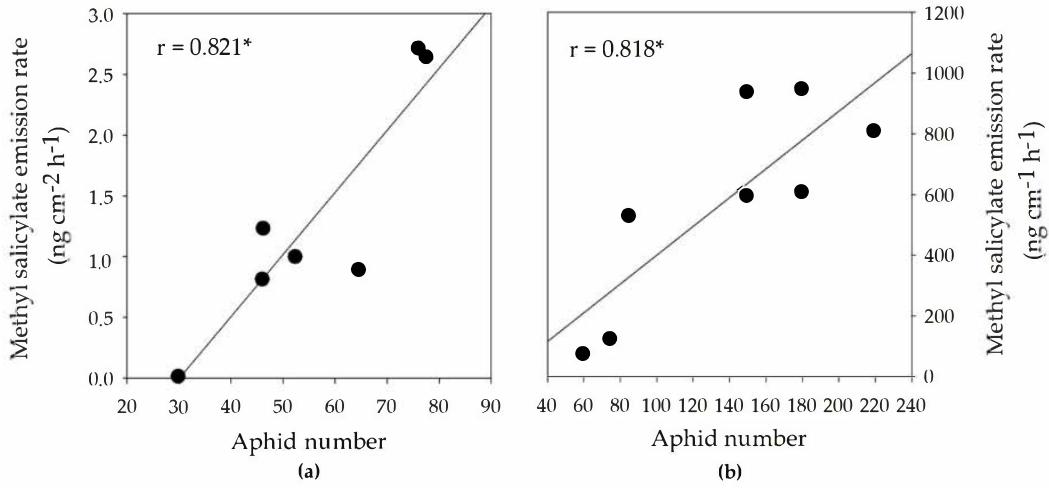
Figure 3. Relationship between the emission rate of methyl salicylate and the number of living aphids. ( a ) Daily average for aphid number and methyl salicylate emissions per needle area; the dots are di ff erent days from infestation in Experiment 1; ( b ) Aphid number and methyl salicylate emissions per shoot length; the dots represent individual saplings analysed 5 weeks after infestation in Experiment 2. r is the Spearman correlation coe ffi cient and * refers to statistical significance ( P <